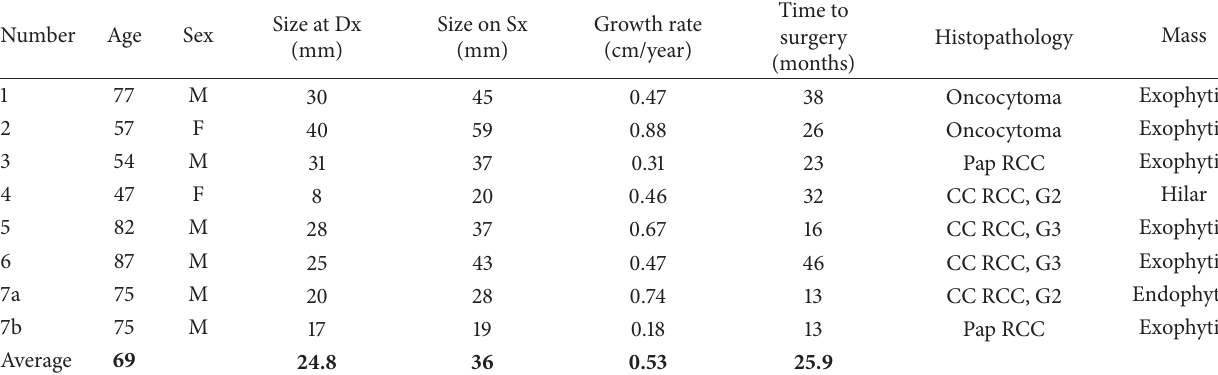
Table 2: Characteristics of patients who underwent NSS.